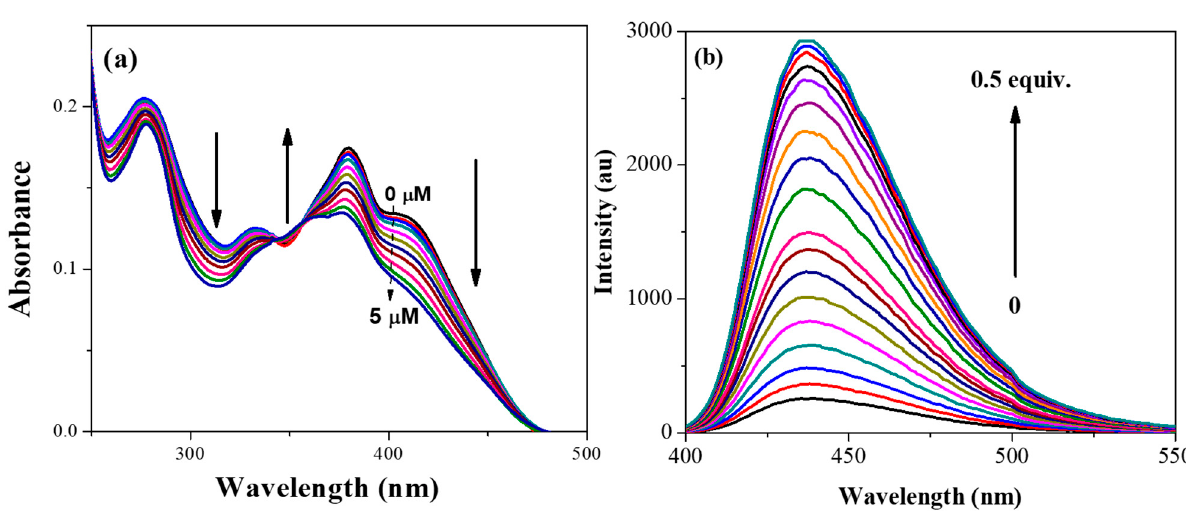
Figure 5. ( a ) UV–vis spectra changes of L (10 µM) with increasing Cu 2+ concentration (0–5 µM) in ethanol–water ( v / v = 7/3, 5 mM HEPES, pH 7.0). ( b ) Fluorescence titration spectra of L (10 µM) with